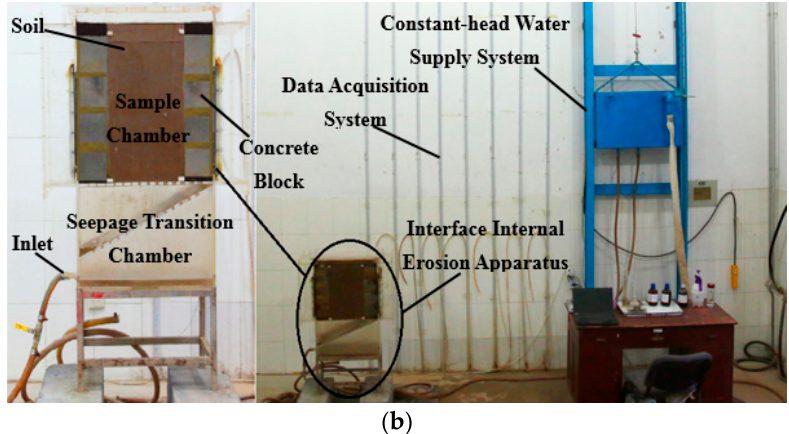
Figure 1. Testing apparatus. ( a ) Schematic graph of interface internal erosion testing system; ( b ) physical testing apparatus.